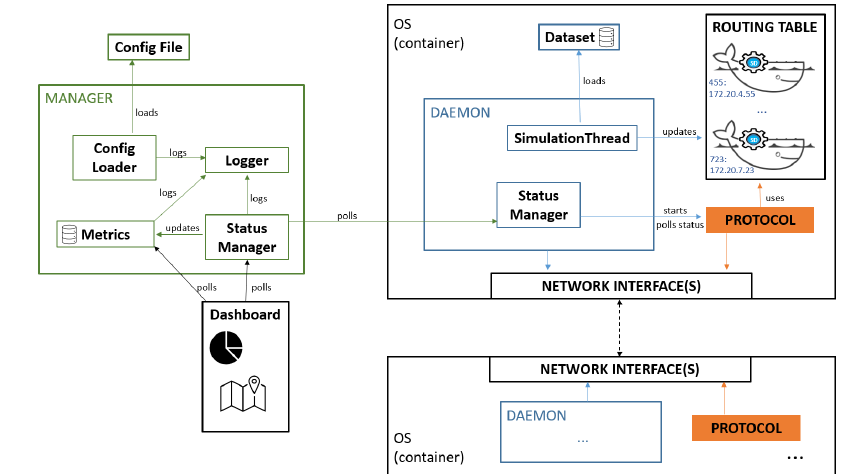
Figure 1. Architecture of the EmuCD